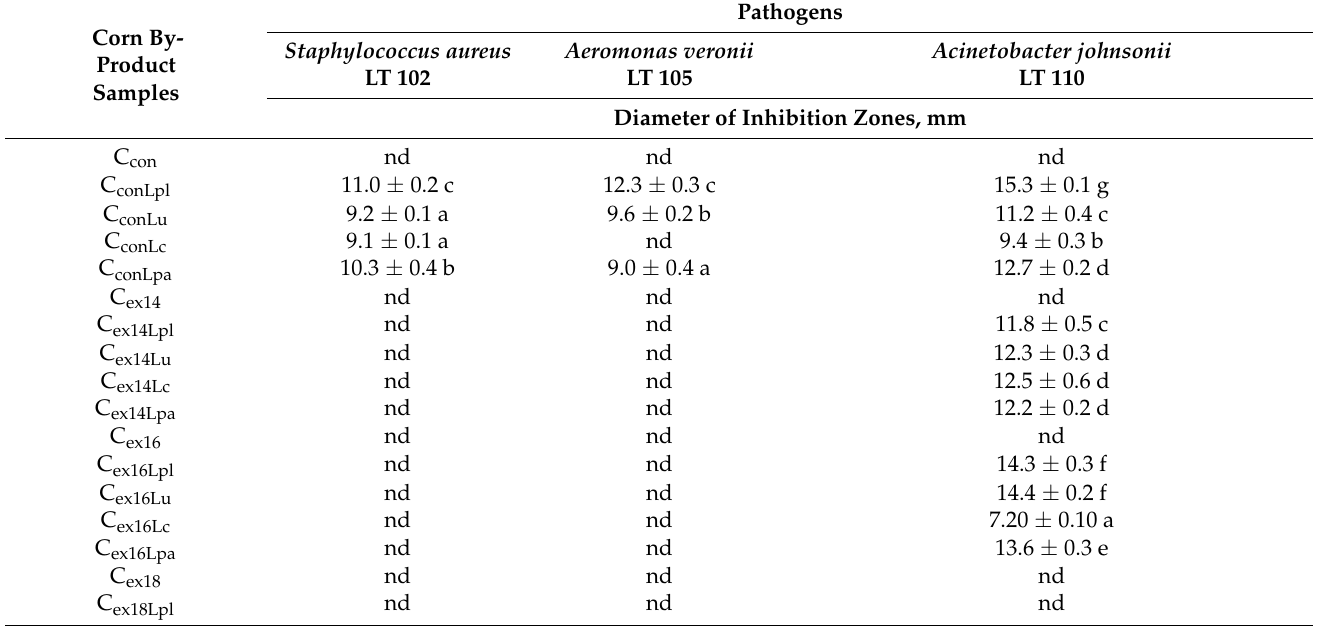
Table 6. Antibacterial properties of non-treated and treated corn by-products.